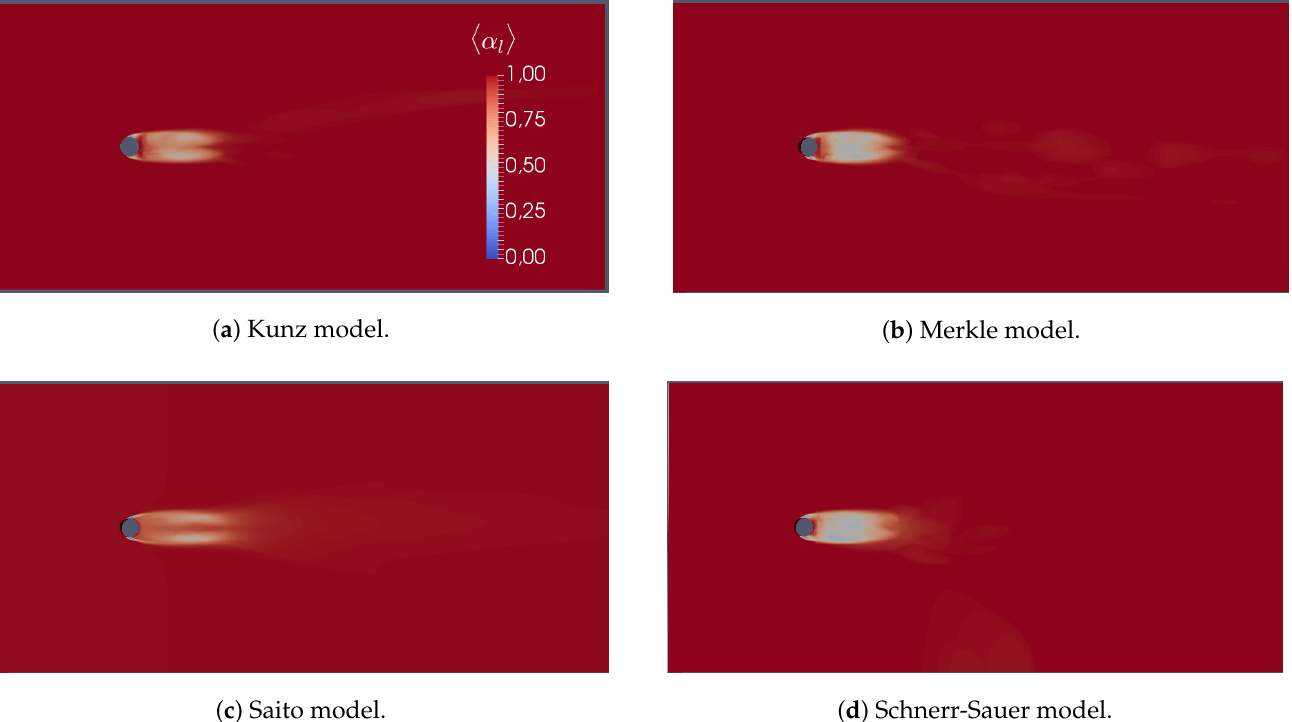
Figure 9. Contour plot of time-averaged liquid fraction, results obtained considering standard